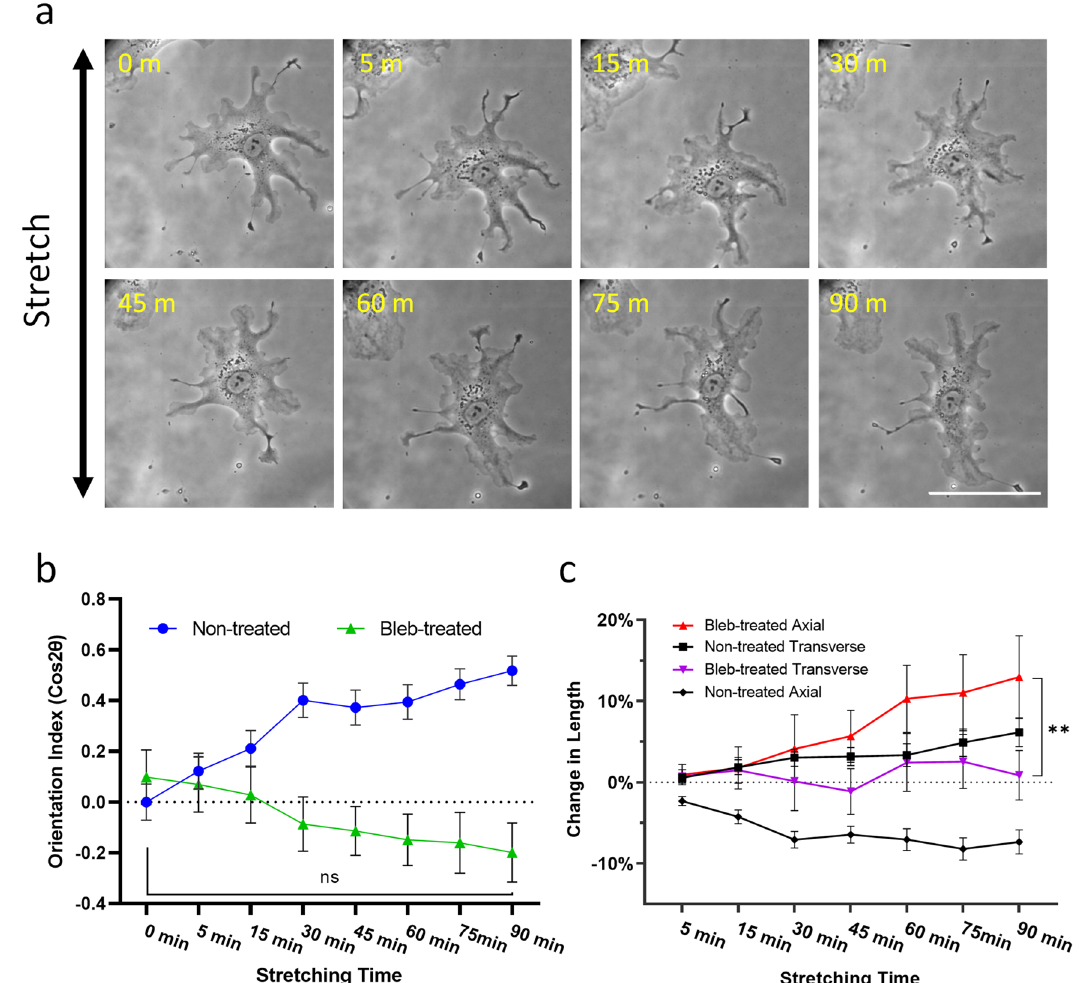
Figure 5. Effect of blebbistatin on cell reorientation and length change in response to cyclic stretching. ( a ) Myosin II activities are inhibited by treating cells with 50 μM blebbistatin for 30 min before applying cyclic stretching. Cells respond by elongating along axial direction (scale bar, 100 μm). ( b ) Unlike control cells (non- treated), blebbistatin-treated cells show weakly significant axial reorientation. ( c ) The response to blebbistatin involves an increase in axial length and an inhibition of transverse elongation (n.s. p > 0.05, ** p < 0.01; n = 46, mean ±